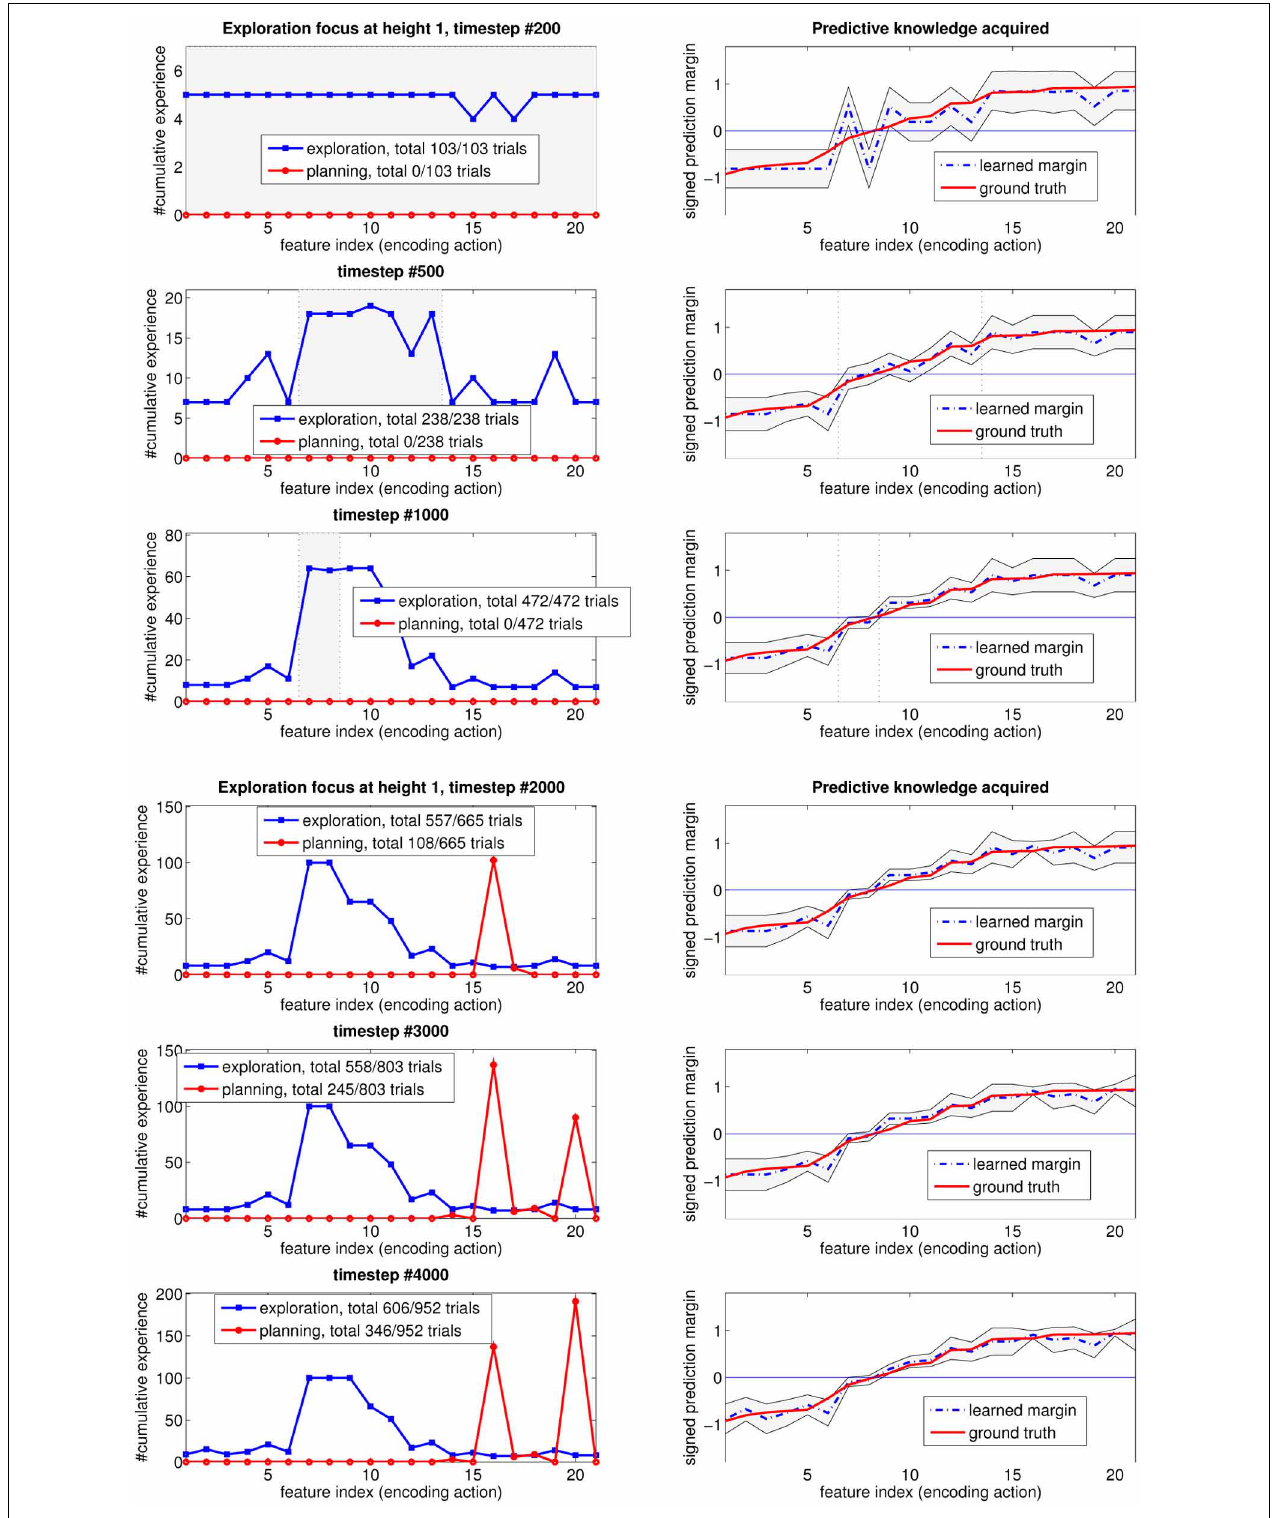
FIGURE 6 | How the focus of the self-generated exploration goals at height 1 changes over time as the learned predictive model gets closer to the true one.